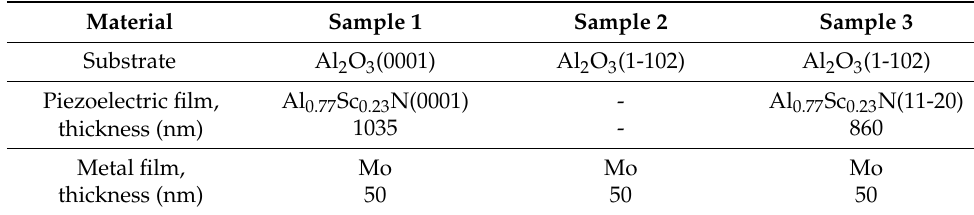
Table 2. Samples investigated in this